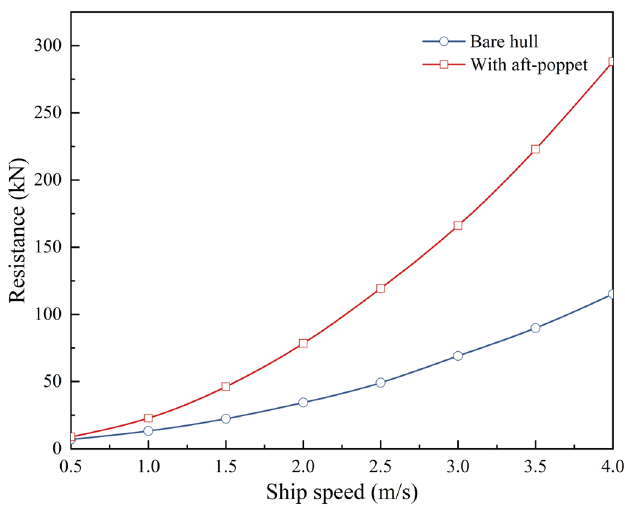
Figure 6. Schematic diagram of ship resistance curves.